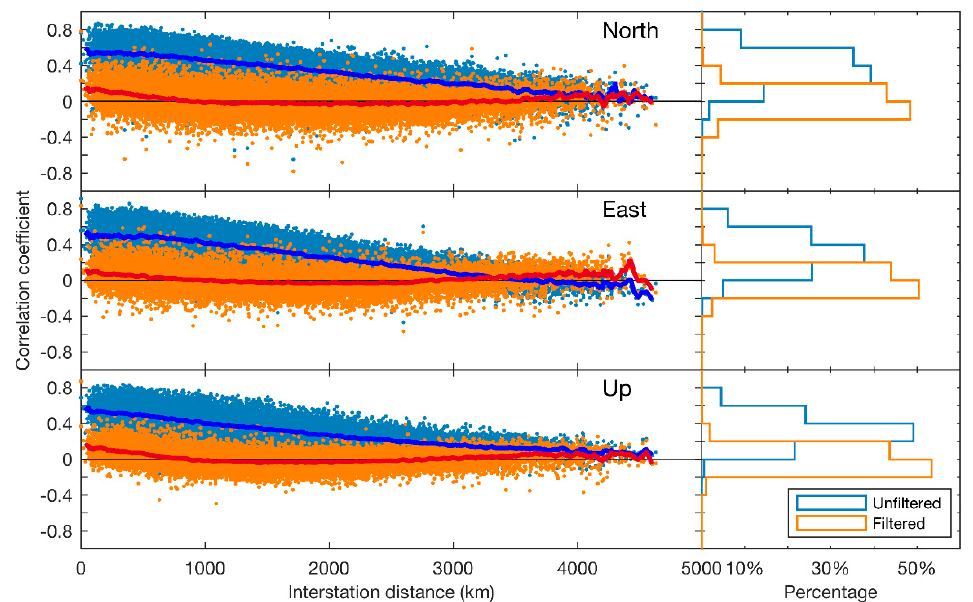
Figure 6. Correlation coefficients between the residual time series of different CMONOC stations as a function of interstation distances in kilometers ( left panels ) and histograms of the interstation correlation coefficients ( right panels ). The interstation correlation coefficients of the unfiltered and filtered time series are shown as blue and orange dot marks, respectively. Moreover, they are smoothed by a boxcar smoother with a full width of 50 km and shown as the blue and red lines, respectively.